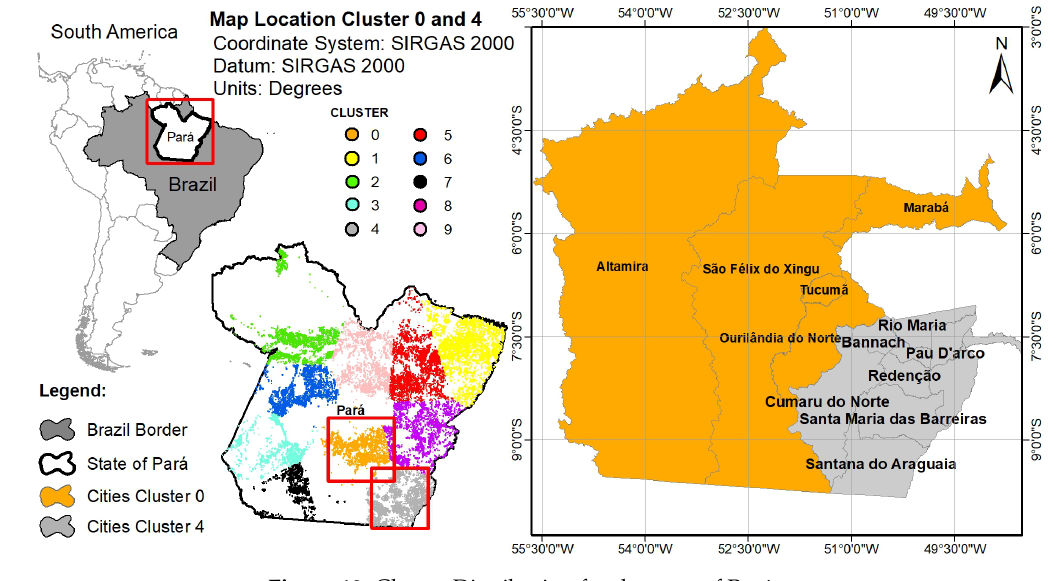
Figure 10. Cluster Distribution for the state of Pará.